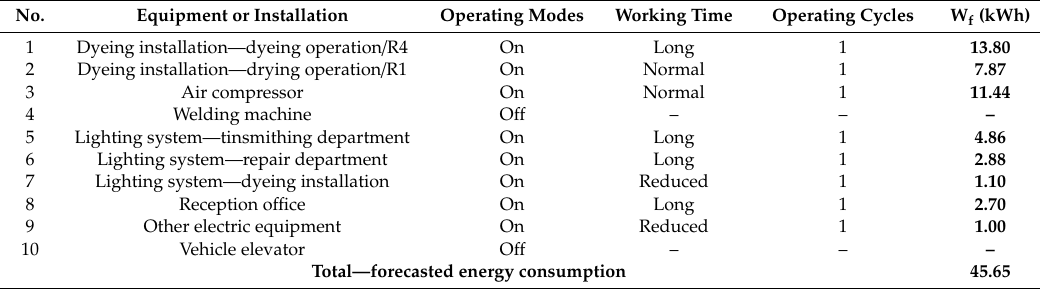
Table A4. The Decision Matrix and forecasted energy consumption for Wednesday.